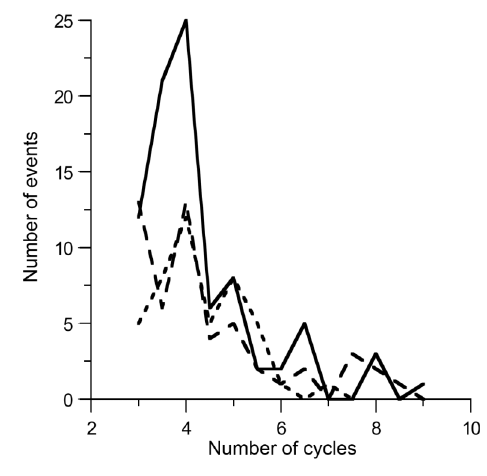
Fig. 3. Spectra of event duration (number of wave cycles) for the 5-day oscillations, Morlet wavelet trans- form for Boulder («absolute» evaluation, solid curve), Akita («relative» evaluation, long-dash curve), and Juliusruh («absolute» evaluation, short-dash